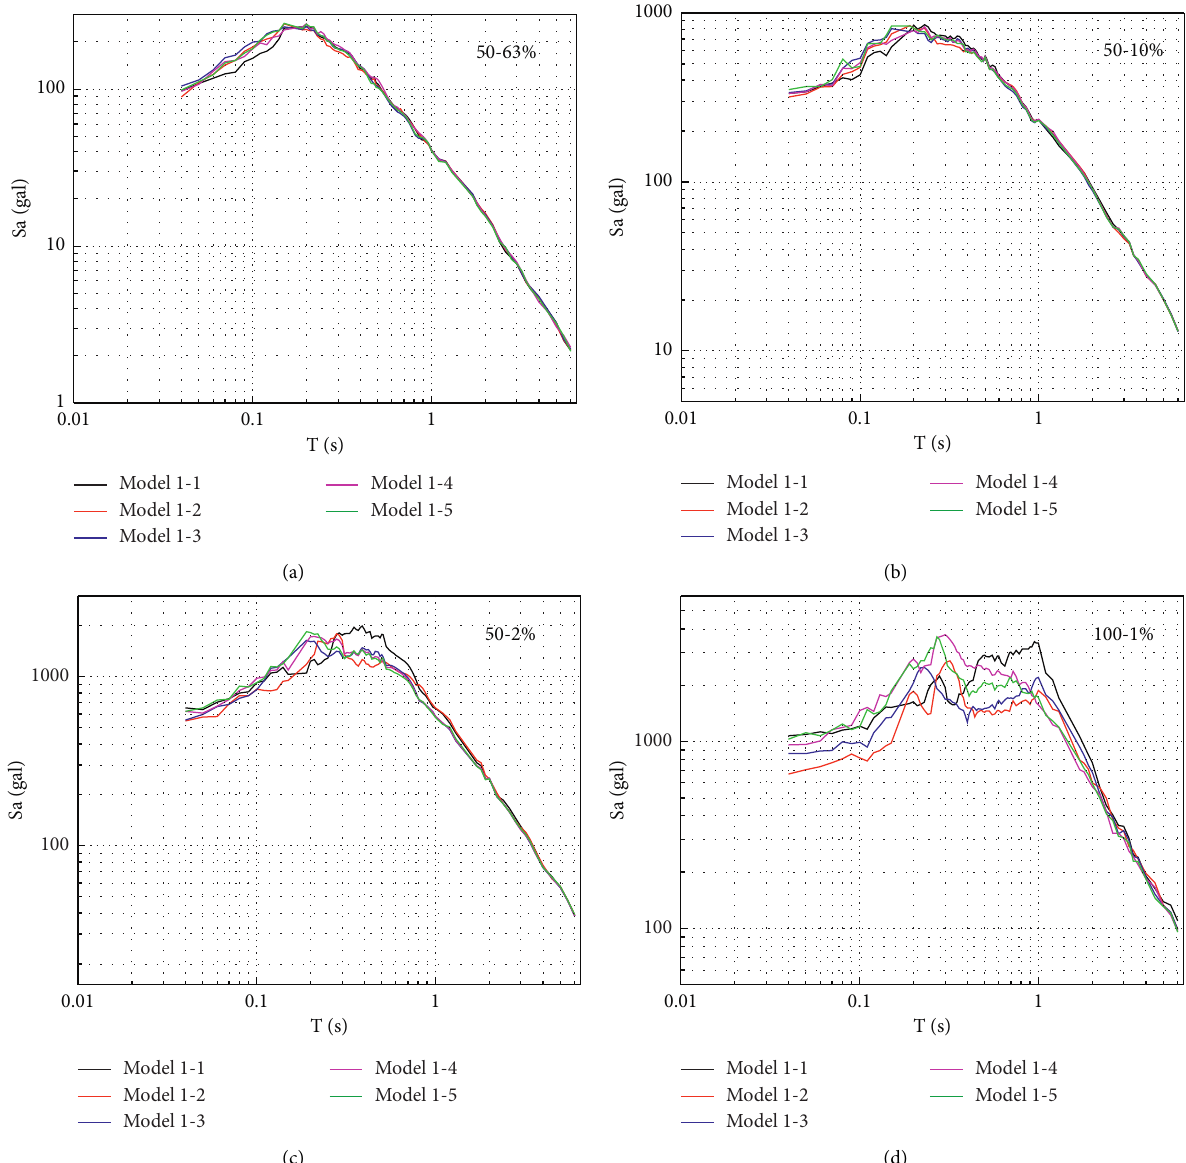
Figure 4: Spectral accelerations for the five single interbedded models under four seismic